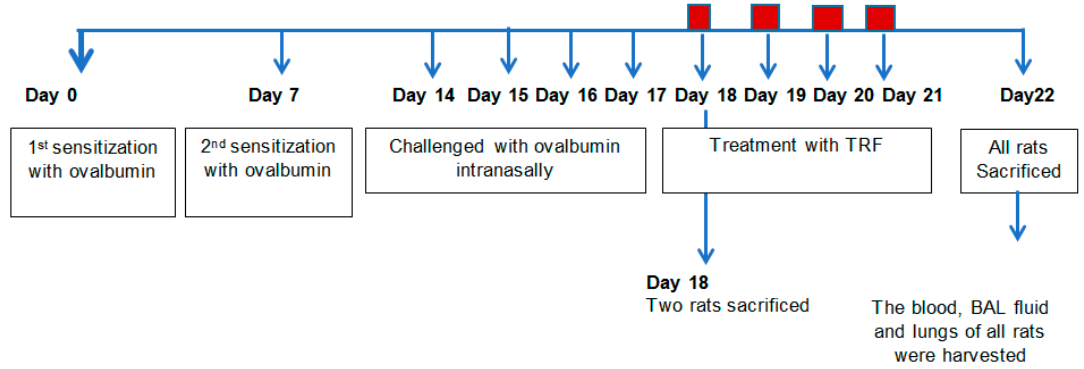
Figure 1. Study design. The time course for treatment protocols is summarized.